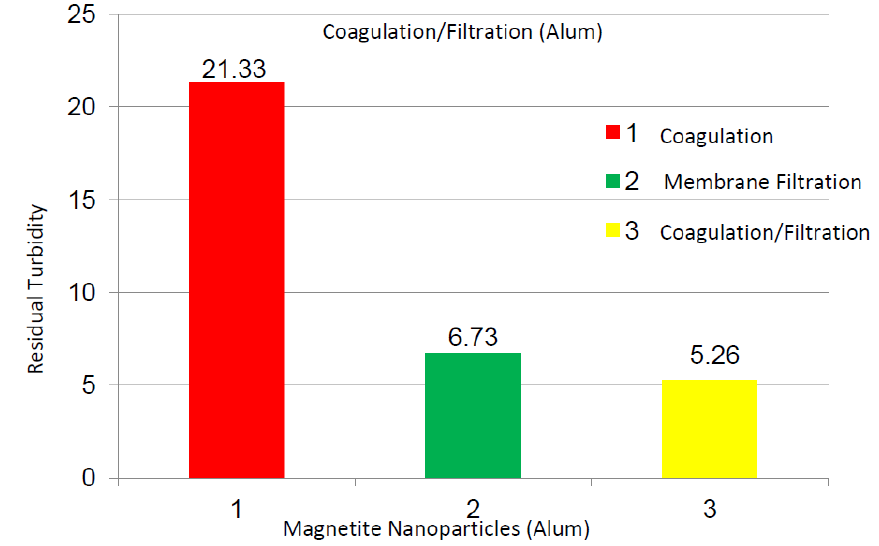
Figure 10. Turbidity values of nanoparticle suspensions using Alum coagulation, membrane filtration, and coagulation + filtration processes; coagulation tests conducted using 10 mg/L Alum after 24 h of settlement in flask.